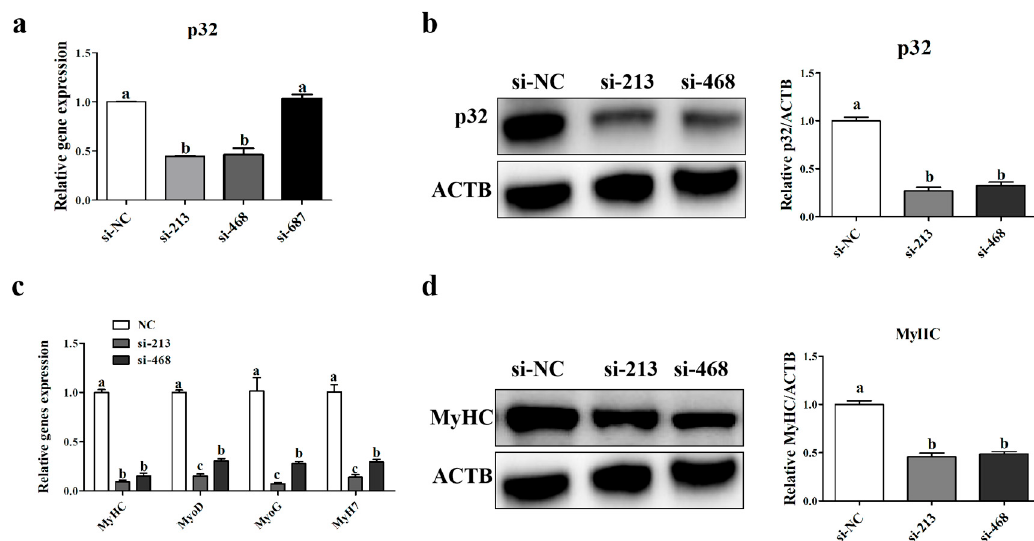
Figure 5. The expression of the p32 mRNA ( a ) of myoblasts was determined at 24 h post-transfection, with the siRNAs targeting p32 (si-213, si-468, si-689, and non-targeting control siRNA (si-NC)) by qRT-PCR ( a ). The expression of the p32 protein was determined at 48 h after transfection with si-213, si-468 and si-NC using Western blot ( b ). The expression level of myosin heavy chain ( MyHC ), MyoD , myogenin ( MyoG ), and myosin heavy chain 7 ( MyH7 ) mRNA was detected at 24 h after transfection with si-213, si-468, and si-NC by qRT-PCR ( c ). The expression of the MyHC protein was determined at 48 h after interference p32 using Western blot ( d ). Expression of gene and protein were normalized to β -actin ( ACTB ) and related to si-NC as mean values ± SEM ( n = 3). a, b, c: different letters denote statistically significant differences within each group; p < 0.05.